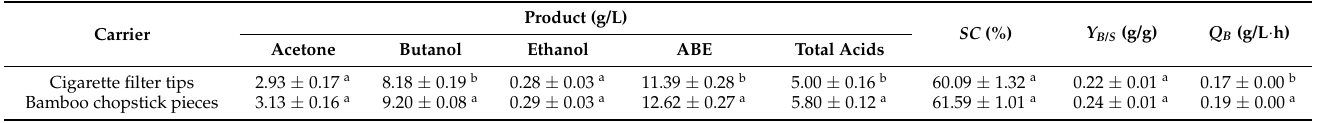
cigarette filter tips and bamboo chopstick pieces at 48 h of fermentation.